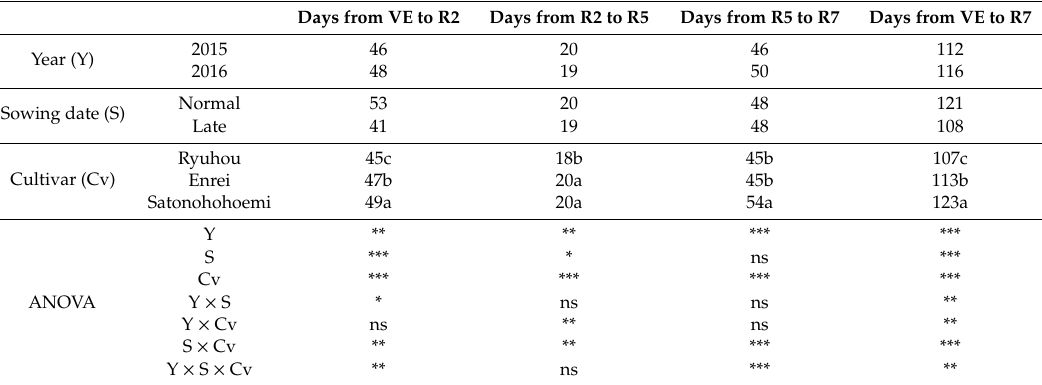
Table 3. Days from emergence (VE) to full flowering (R2), from R2 to the beginning of seed filling (R5), from R5 to the beginning of maturity (R7), and from VE to R7 for three soybean cultivars (Ryuhou, Enrei, Satonohohoemi) with normal and late sowing dates in 2015 and 2016 in the Tohoku region of northern Japan. Days from VE to R2 Days from R2 to R5 Days from R5 to